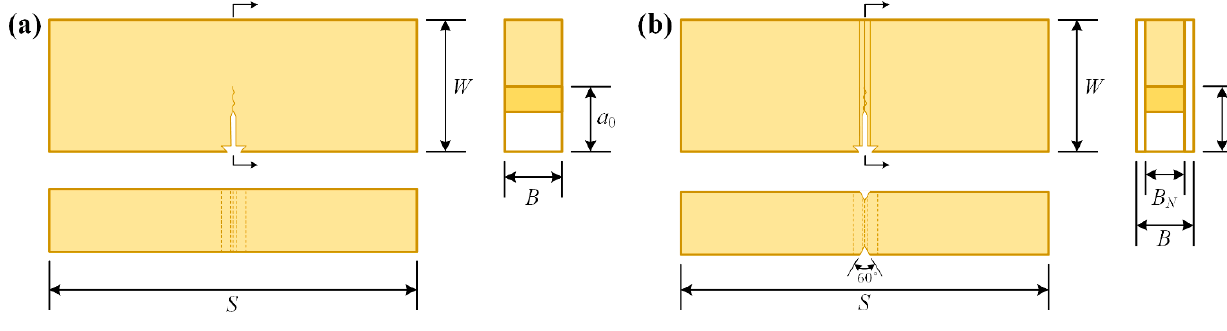
Figure 3. Geometric model of two types of specimens: ( a ) specimen without side grooves; ( b ) specimen with side grooves. Table 3. Dimensions of four different specimens.